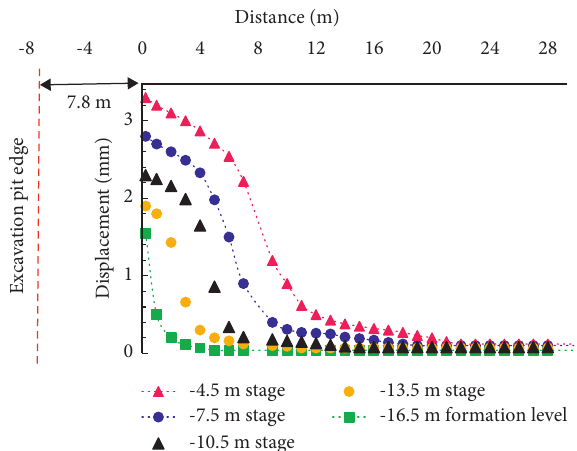
Figure 9: Relative ground displacement from 30# bridge pile group foundation with the application of steel bracing support alone.